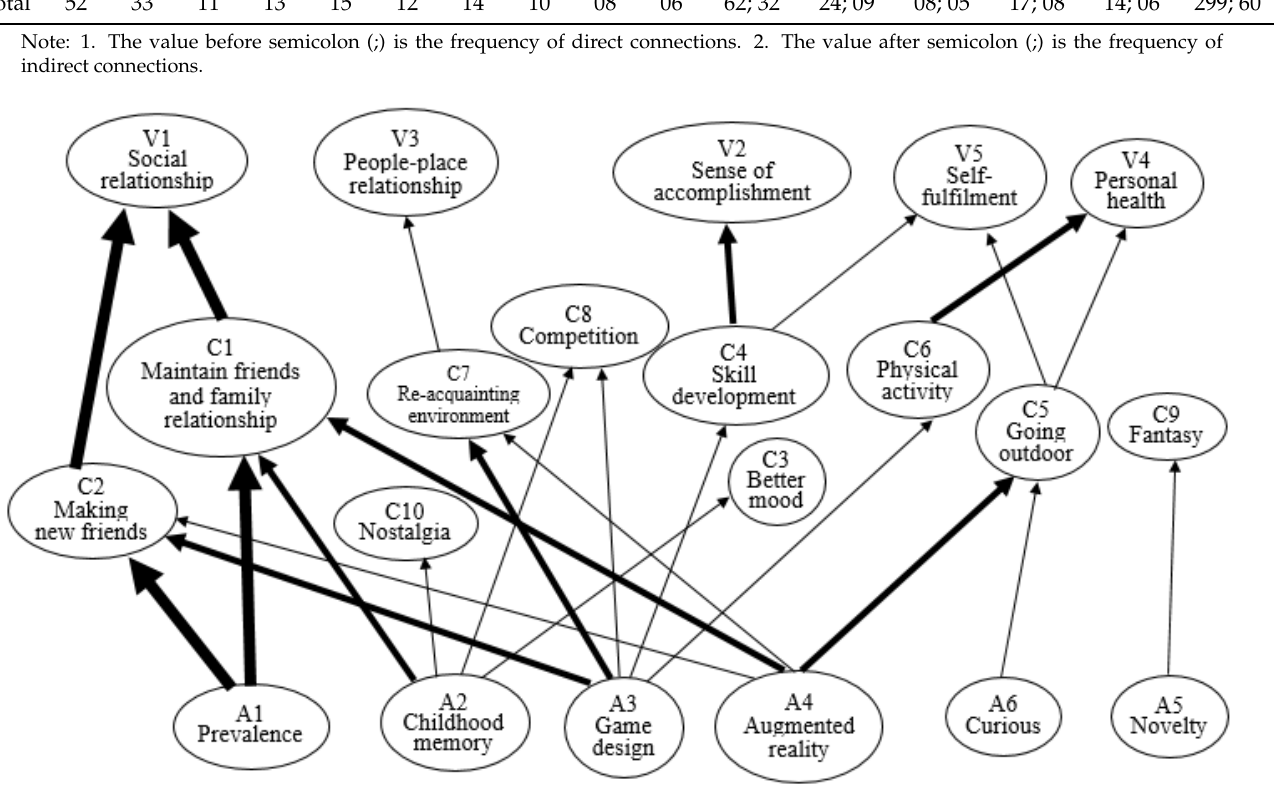
Figure 1. HVM for Pokémon Go experiences.